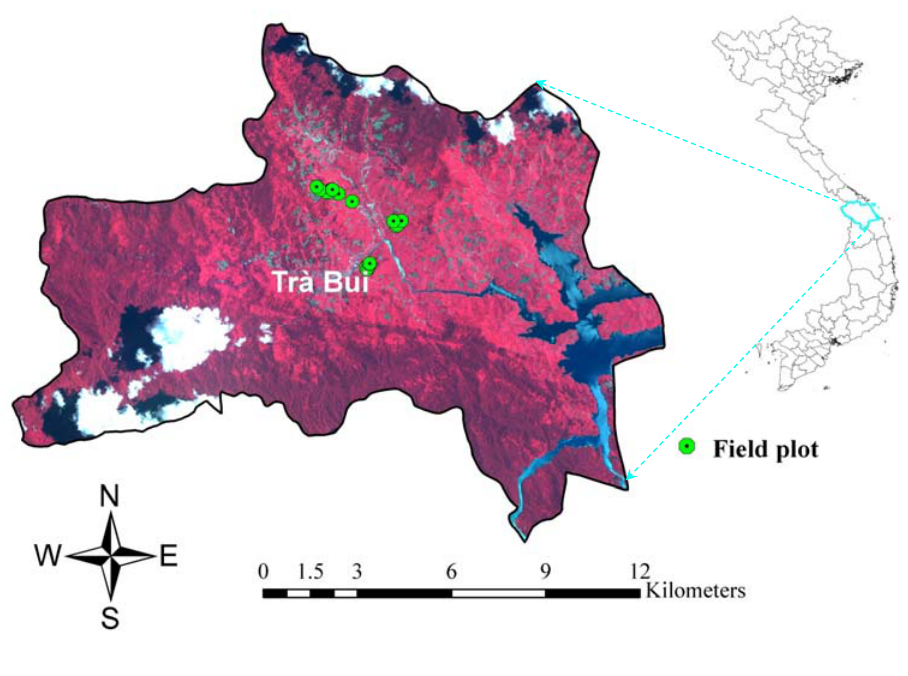
Figure 4. The study area overlaid with Spot remote sensing image and community measured field